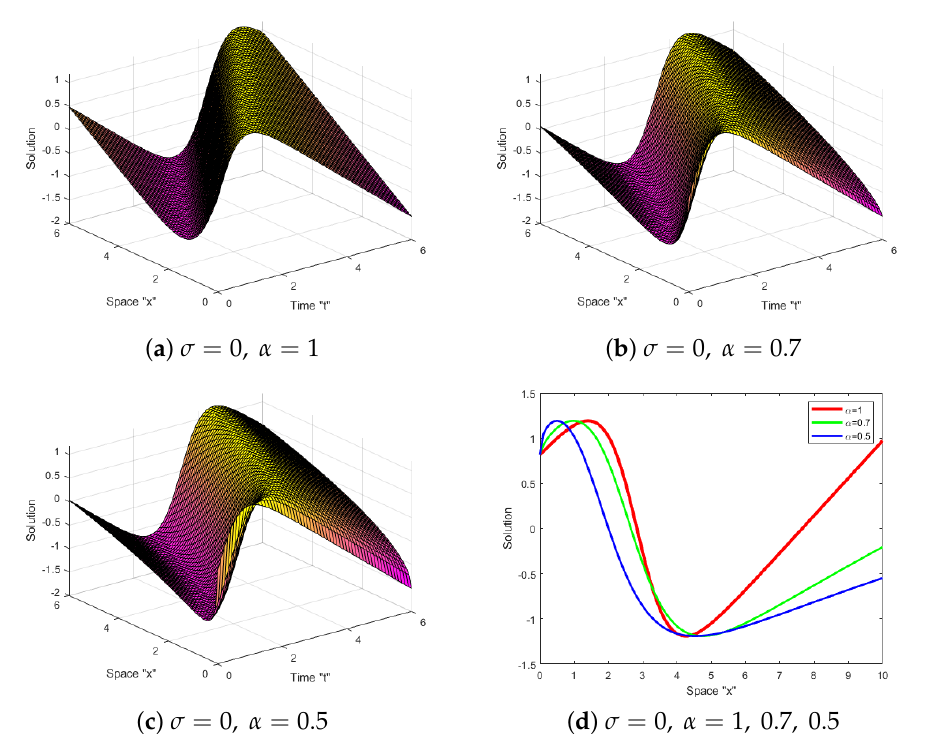
Figure 3. ( a – c ) show the 3D profiles of Equation (19) with σ = 0, c 0 = − 4, and different values of α . ( d ) indicates the 2D profile of Equation